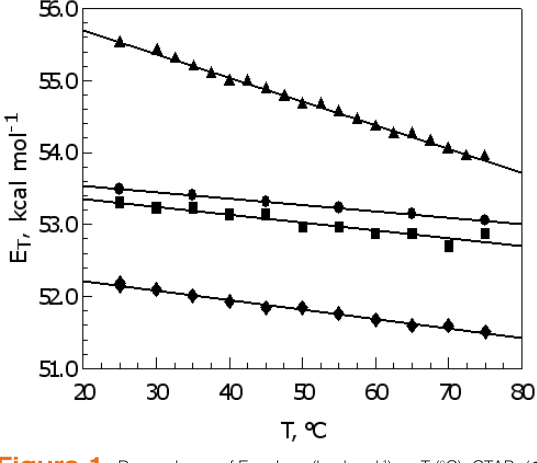
Figure 1. Dependence of E values (kcal mol -1 ) on T (°C). CTABr (  ), T CTANO (  ), CTBABr (  ), MeOH (  3